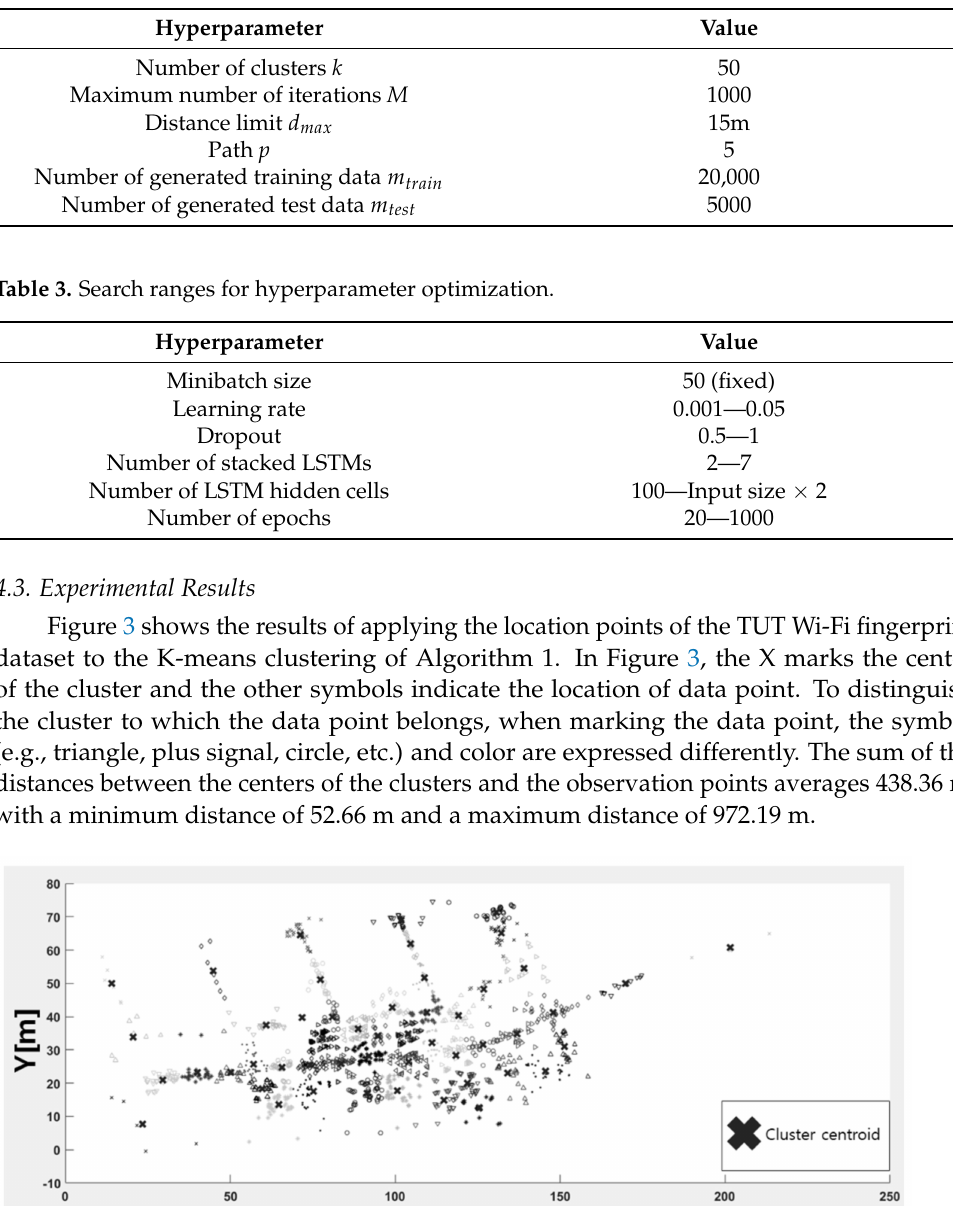
Table 2. Hyperparameters for movement path data generation.